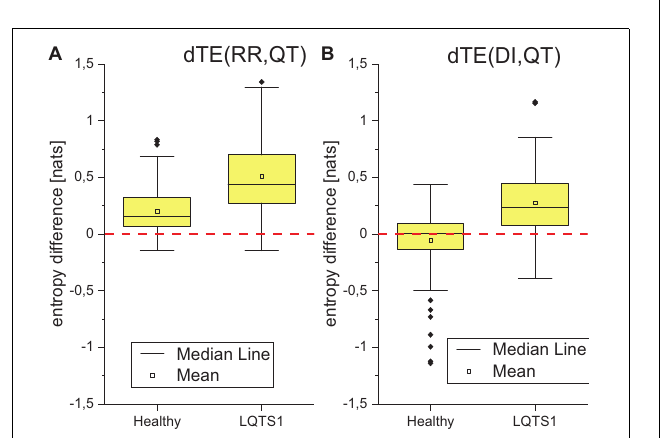
FIGURE 8 | (A) Boxplot of the difference between TE in both directions for the heart rhythm (RR intervals) and the repolarization (QT intervals). (B) Boxplot of the difference between TE in both directions for the diastolic interval series (diastolic intervals) and the repolarization (QT intervals). p -Values: dTE(RR,QT): 8.57094E-9; dTE(DI,QT): 7.55201E-8.